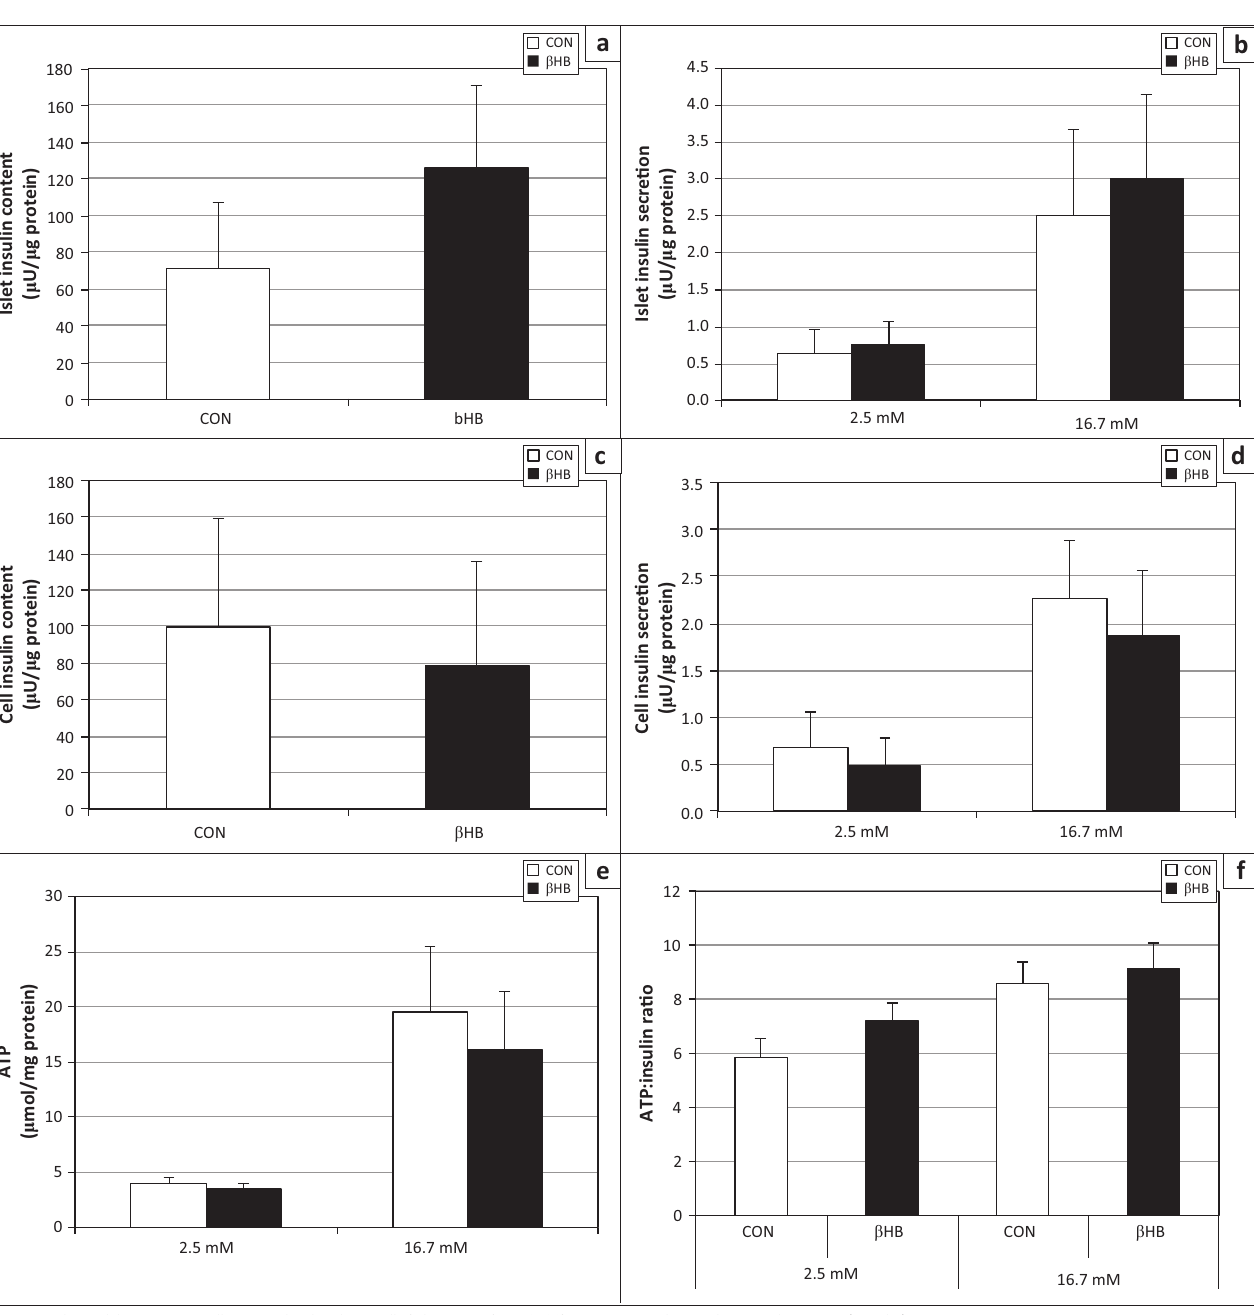
FIGURE 4: β -Hydroxybutyrate maintains insulin content and glucose-stimulated insulin secretion in primary rat islets and INS-1 832/13 β -cells. Primary rat islets and INS-1 832/13 β -cells were cultured for 48 h with vehicle (CON) or 10 mM β -Hydroxybutyrate (bHB) after which (a and c; n = 3) total insulin content and (b and d; n = 3) glucose- stimulated insulin secretion was measured for islets (a and b) or INS-1 832/13 β -cells (c and d). Total ATP was measured in identical conditions (e; n = 3), and the ATP:insulin ratio was determined (f; n =